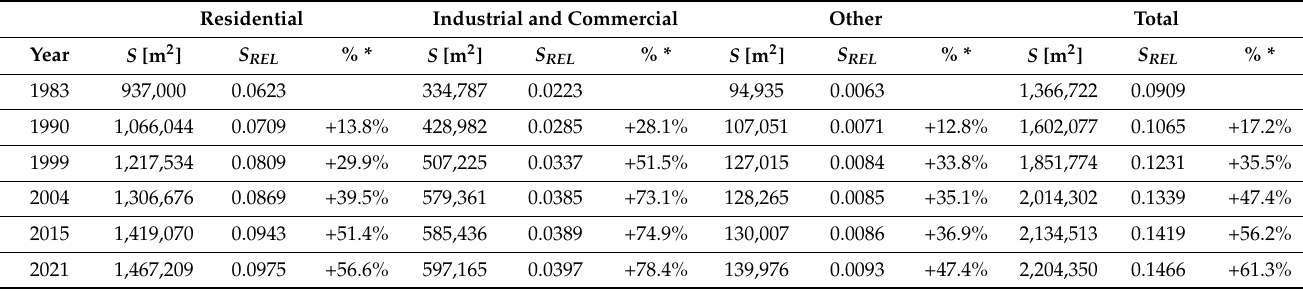
Table 1. Absolute ( S ) and relative ( S REL ) footprint surface area and their increase compared to the 1983 layout, for di ff erent building categories in the study area during the last 40 years.